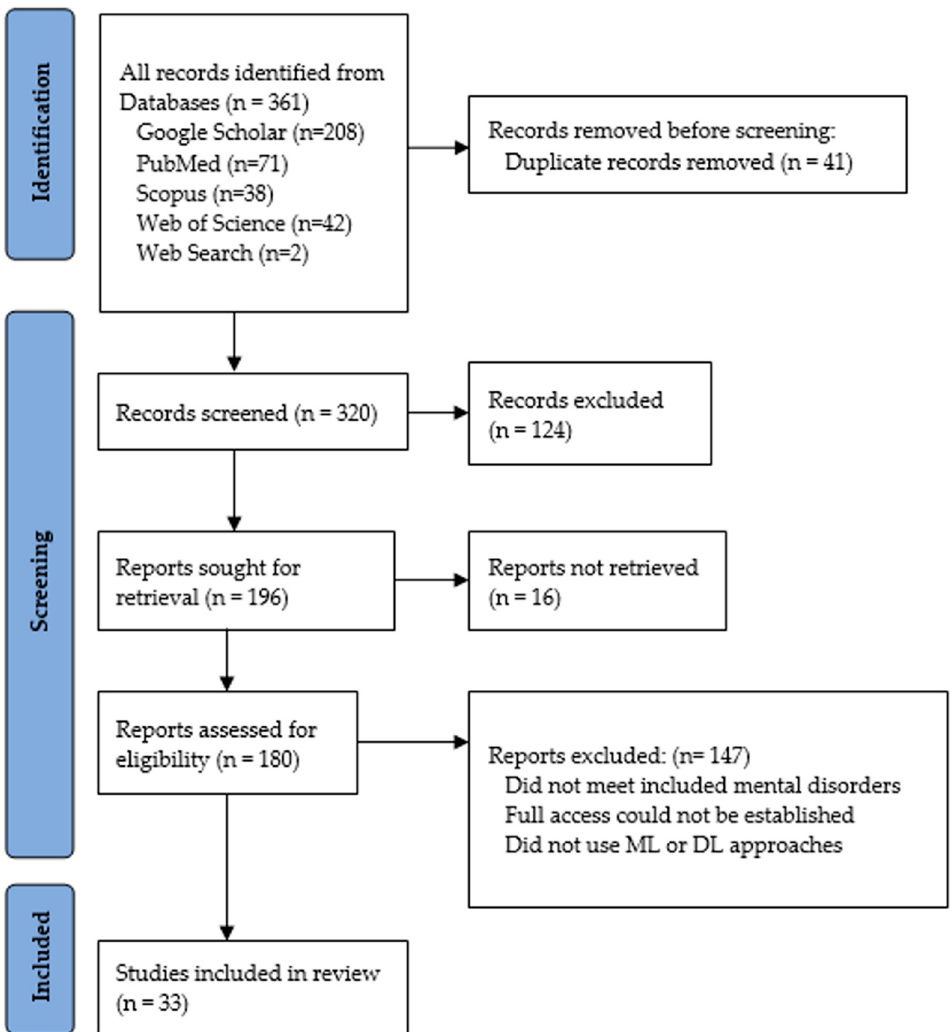
Figure 3. PRISMA flow diagram of the study selection process.